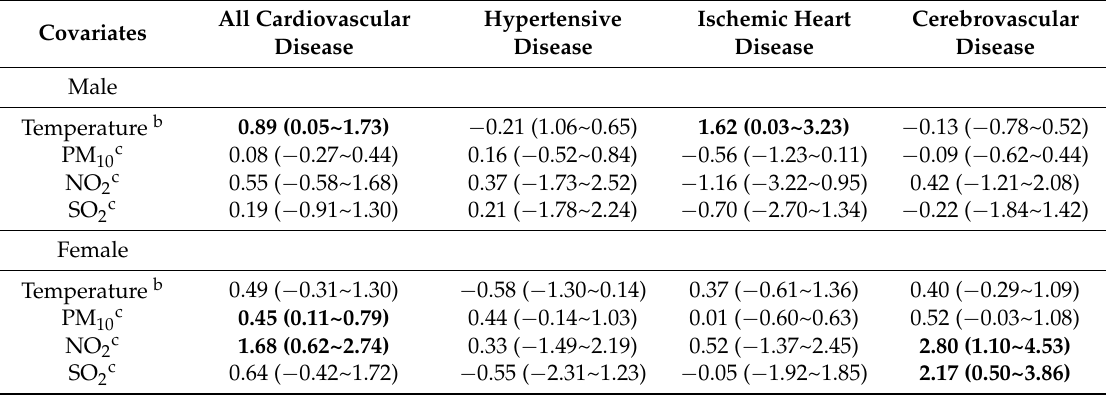
Table A1. Percent increase (mean and 95% CI) of the elderly ER admissions with a 1 ˝ C variation in mean temperature and a 10- µ g/m 3 increase in air pollutant concentrations by gender in Beijing